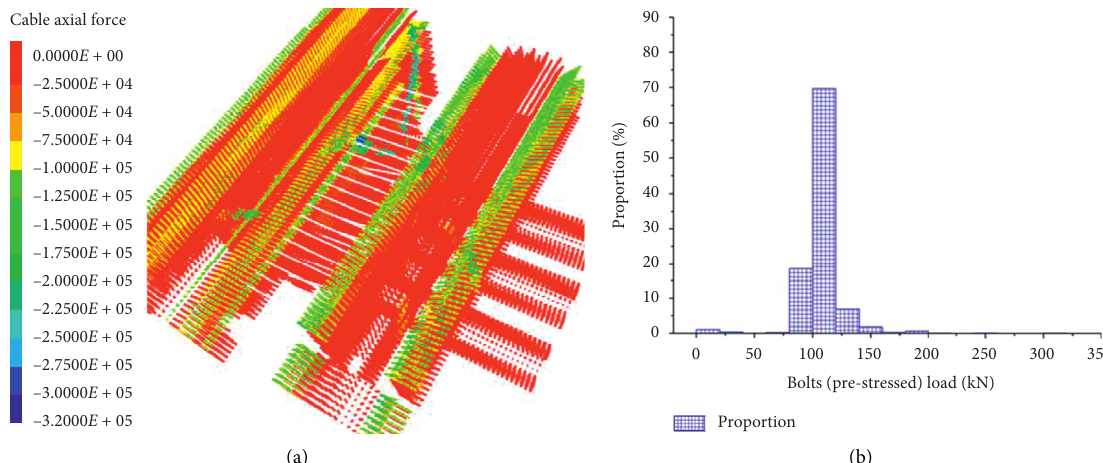
Figure 12: Cable axial force distribution of the bolt support (negative sign indicates tension) (a). Axial force distribution of prestressed cables proportion (b).